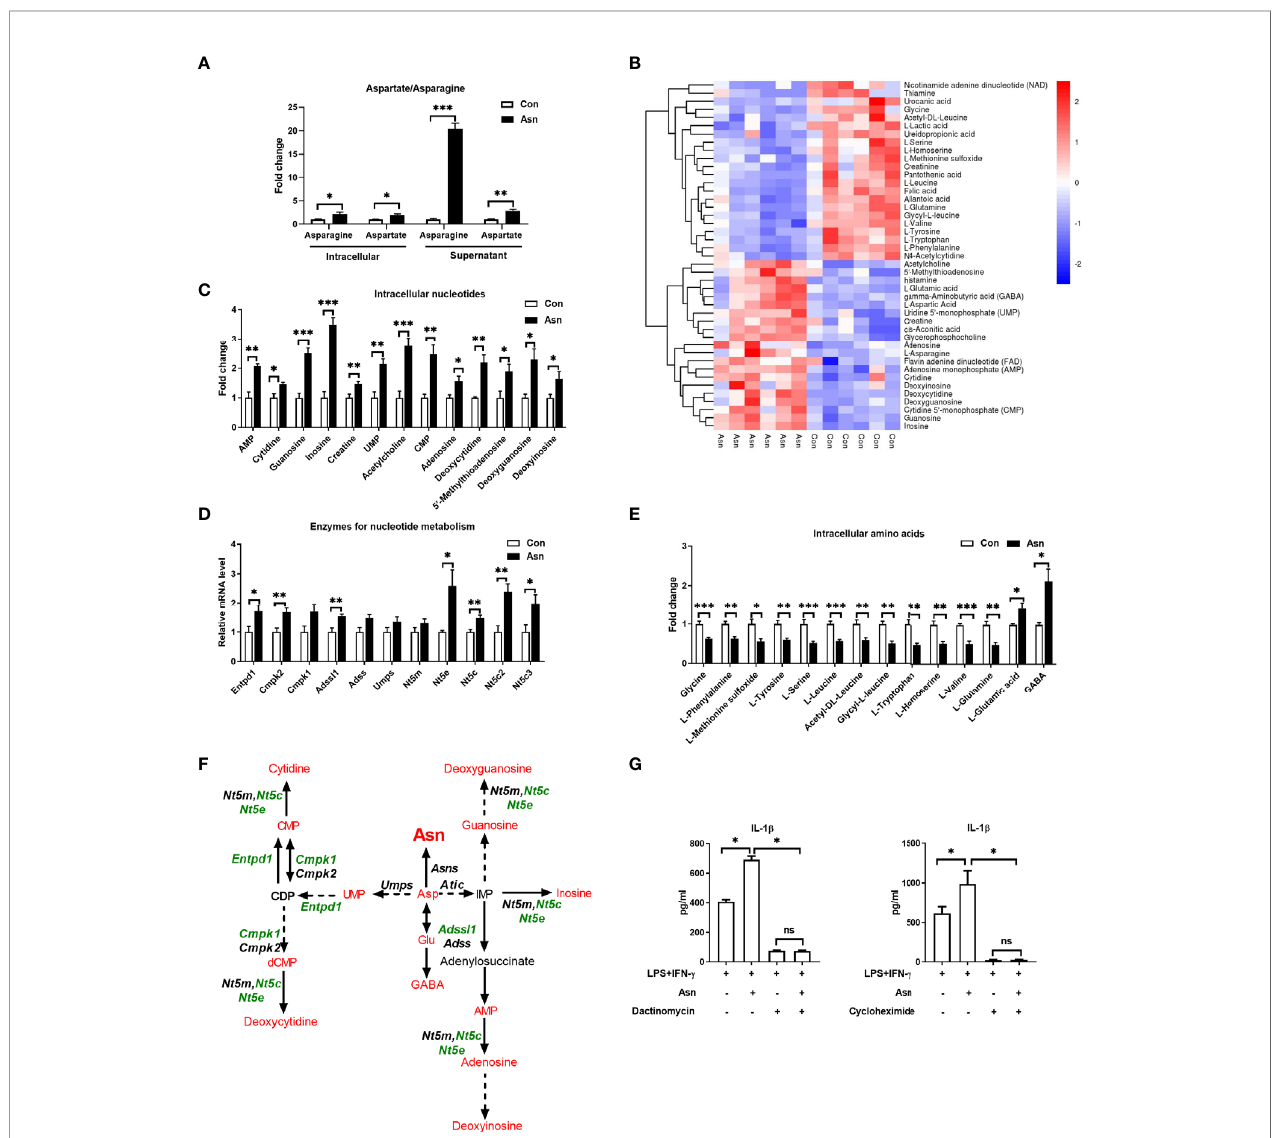
FIGURE 5 | Asparagine modulates the cellular metabolism of macrophages. (A) Fold change of intracellular and supernatant asparagine/aspartate in M1 macrophages and asparagine-treated M1 macrophages ( n = 6). (B) Heatmap analysis of the different metabolites between M1 macrophages and asparagine-treated M1 macrophages ( n = 6). (C) Fold change of the intracellular nucleotides in M1 macrophages and asparagine-treated M1 macrophages ( n = 6). (D) mRNA expressions of the rate-limiting enzymes for nucleoside synthesis in M1 macrophages and asparagine-treated M1 macrophages ( n = 6). (E) Fold change of the intracellular amino acids in M1 macrophages and asparagine-treated M1 macrophages ( n = 6). (F) Different metabolites in aspartate metabolism between M1 macrophages and asparagine-treated macrophages ( n = 6). (G) Secretion of interleukin 1 b (IL-1 b ) from M1 macrophages with asparagine supplementation combined with dactinomycin or cycloheximide ( n = 4). Data were analyzed with unpaired t -test (A, C – E) or with one-way ANOVA (G) . Error bars represent the mean ± SEM. ns, not signi fi cant. * p ≤ 0.05, ** p ≤ 0.01, *** p ≤